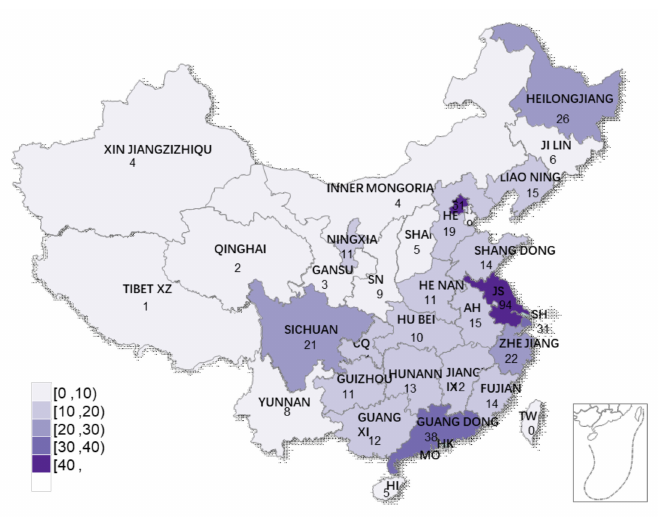
Figure 3. Survey sample